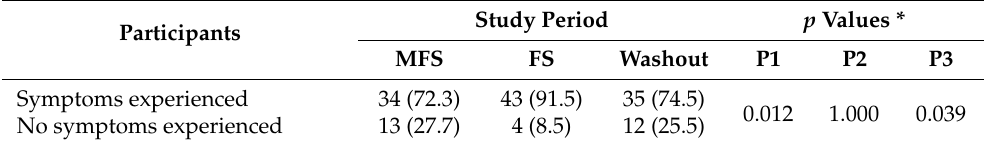
Table 2. Number and percentage of participants experiencing at least one symptom related to iron consumption.